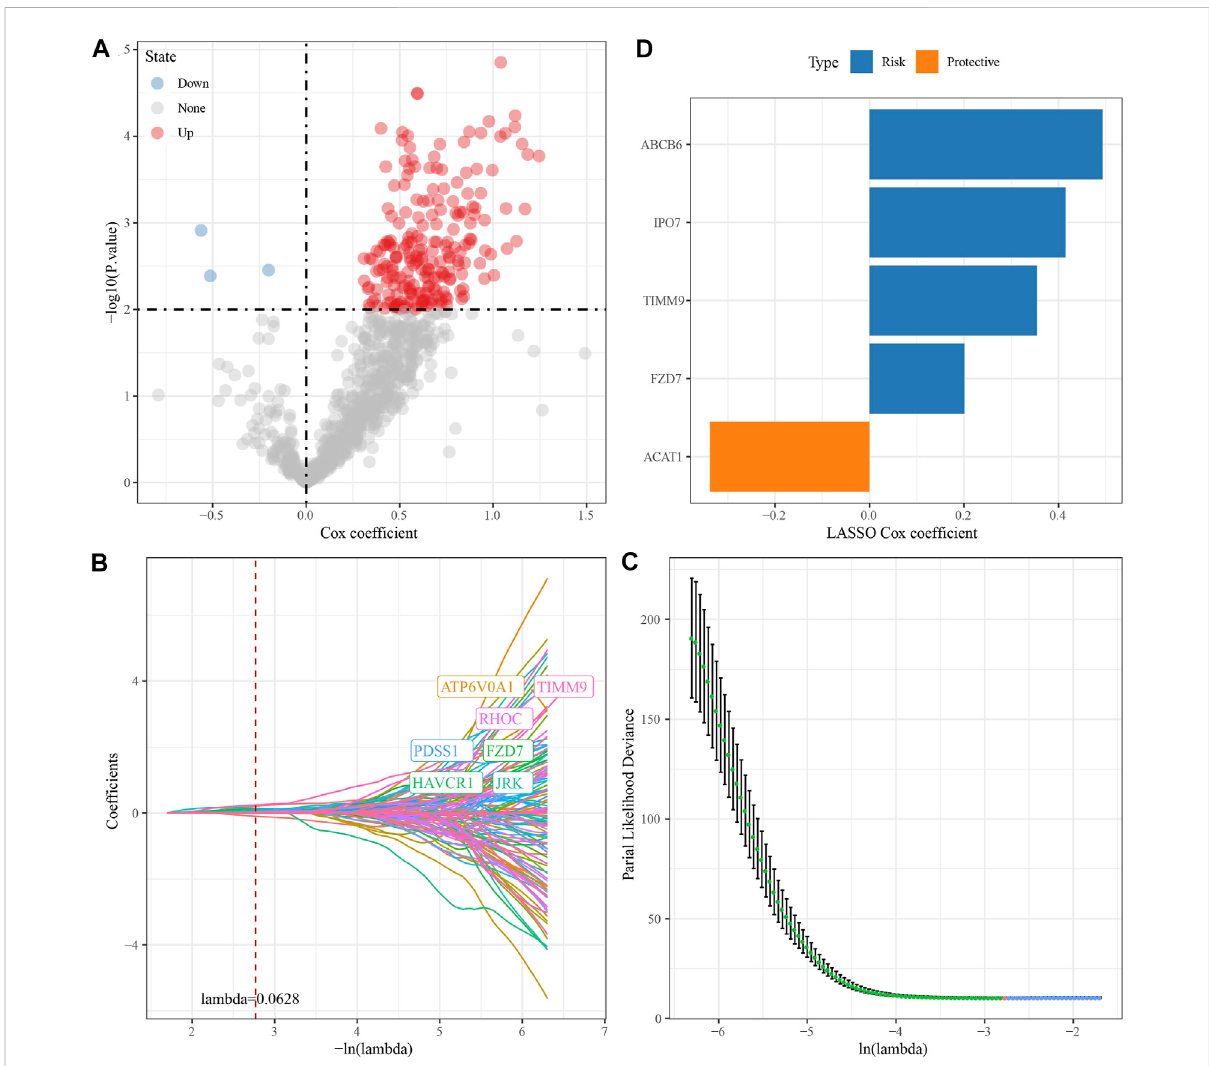
FIGURE 3 Construction of HBV gene prognostic model for HCC. (A) Analysis results of DEGs; (B) The locus of each independent variable changing with lambda; (C) CI under lambda; (D) Lasso coef fi cient distribution of HBV-related gene